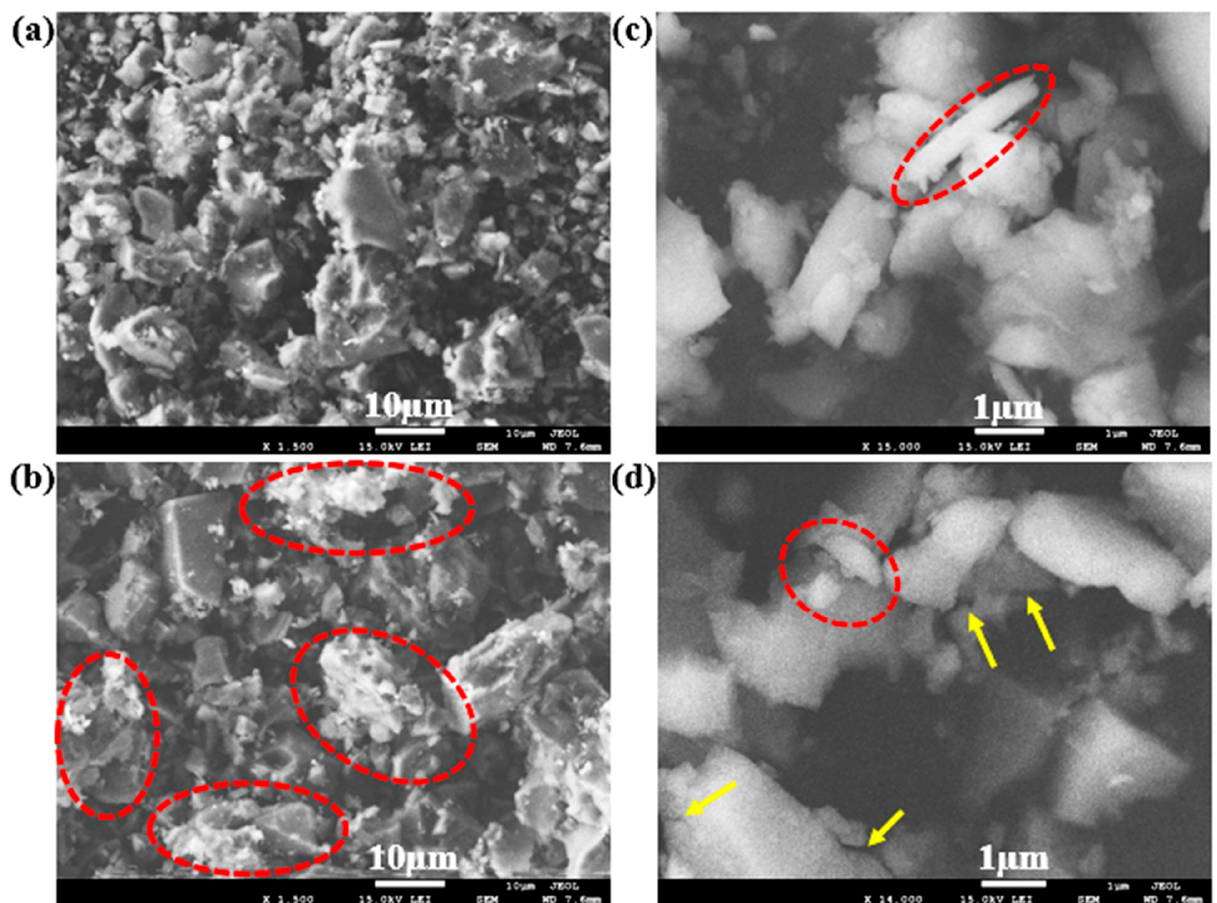
Energies 2021 , 14 , x FOR PEER REVIEW 14 of 21 Figure 11. SEM micrographs of the microschist samples: ( a ) sample at 22 °C (1500×), ( b ) sample at 800 °C (1500×), ( c ) sample Figure 11. SEM micrographs of the microschist samples: ( a ) sample at 22 ◦ C (1500 × ), ( b ) sample at 800 ◦ C (1500 × ), at 22 °C (14,000×), ( d ) sample at 800 °C (14,000×). ( c ) sample at 22 ◦ C (14,000 × ), ( d ) sample at 800 ◦ C (14,000 × ).